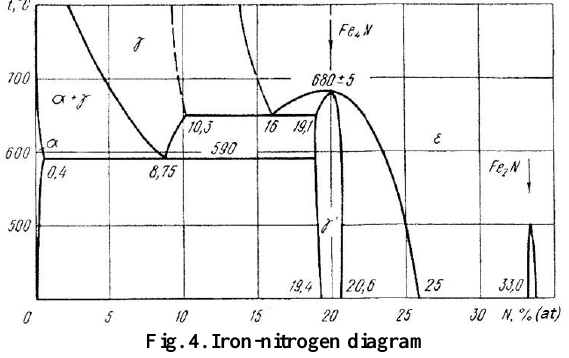
Fig. 4. Iron-nitrogen diagram